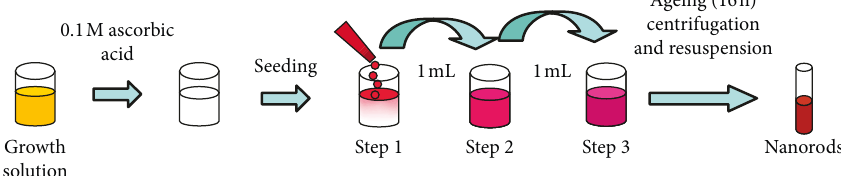
Figure 8: The general scheme used for the three step seed-mediated method [95]. Table 1: Summary of properties, synthesis, characterization, and applications of AuNRs